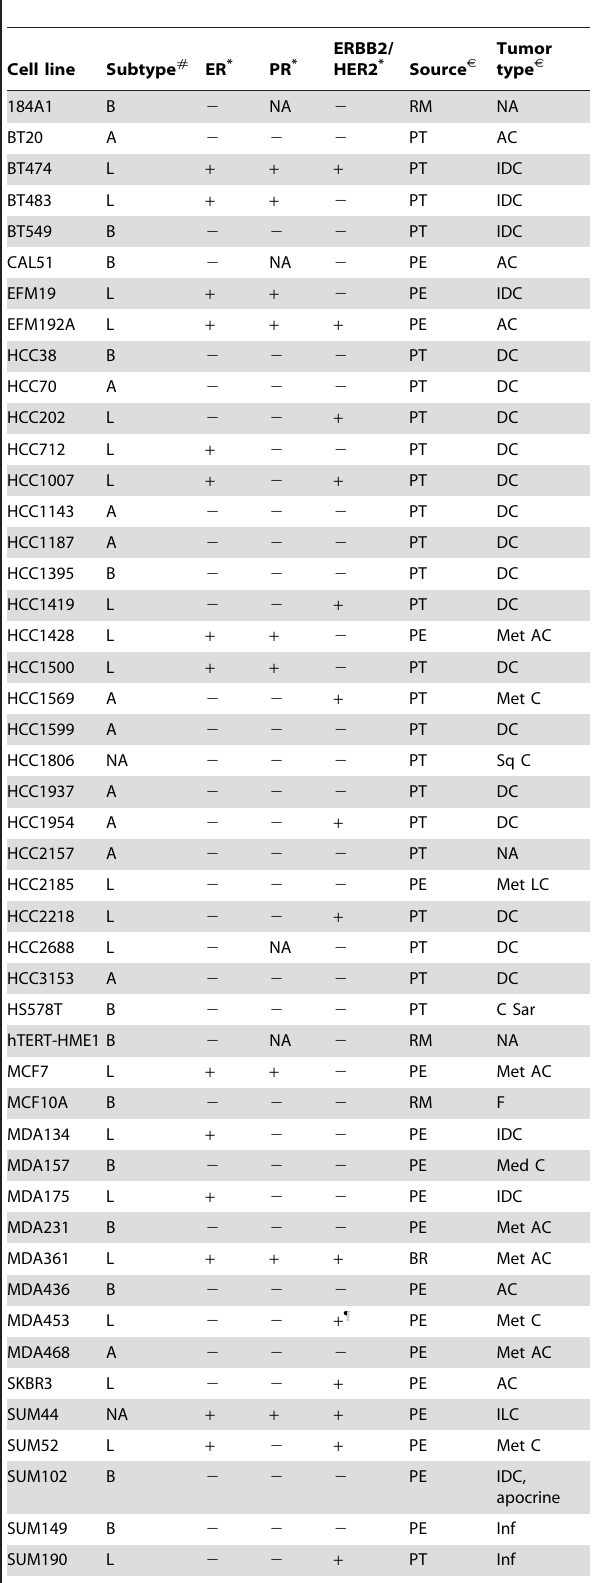
Table 1. Clinicopathological features of breast cancer cell